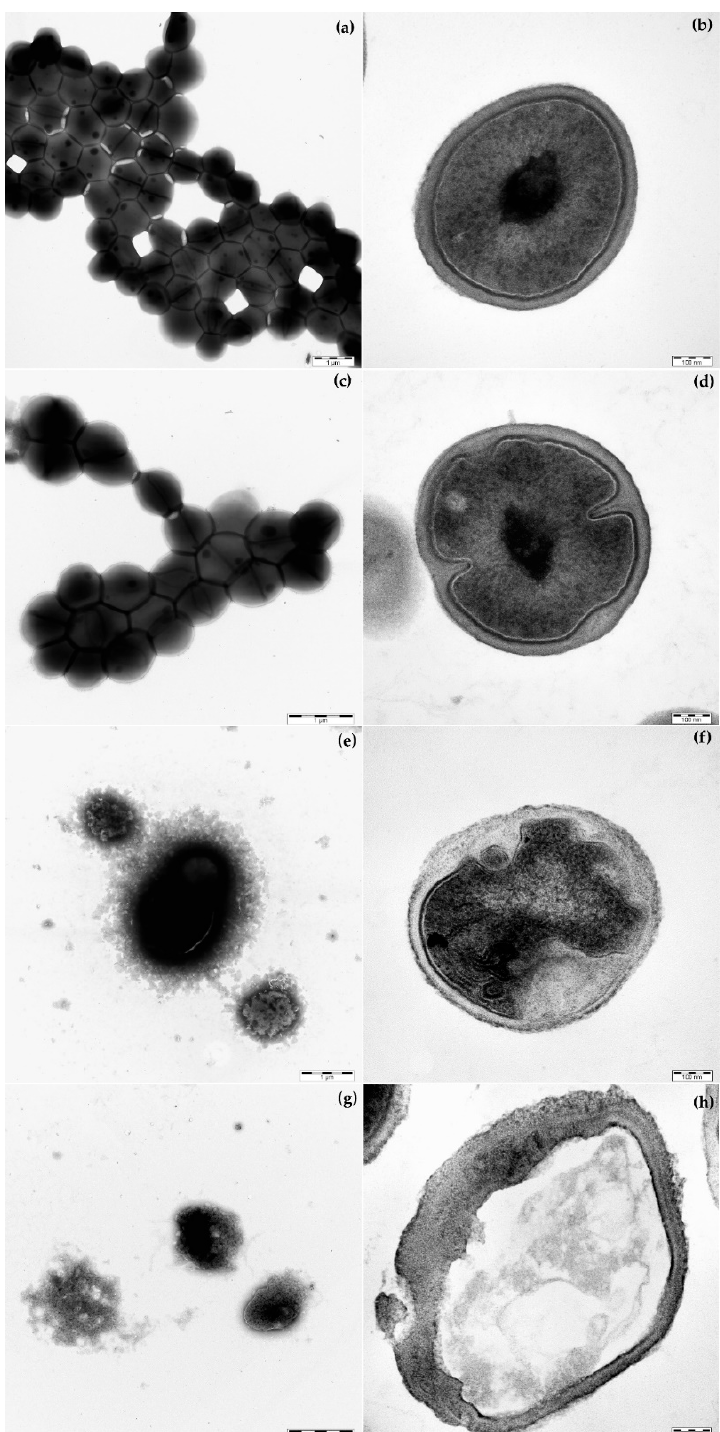
Figure 2. Transmission electron microscopy images of Staphylococcus epidermidis CNCTC 5671 affected by tetracycline (TET) and sodium salt of cobalt bis-dicarbollide (COSAN.Na) alone or their combination. ( a ) untreated control sample—negative staining; ( b ) untreated control sample— ultra-thin section; ( c ) TET 4.5 µ g/mL—negative staining; ( d ) TET 4.5 µ g/mL—ultra-thin section; ( e ) COSAN.Na 2.24 µ g/mL—negative staining; ( f ) COSAN.Na 2.24 µ g/mL—ultra-thin section; ( g ) TET 4.5 µ g/mL + COSAN.Na 2.24 µ g/mL—negative staining; ( h ) TET 4.5 µ g/mL + COSAN.Na 2.24 µ g/mL—ultra-thin section. Scale bar = 1 µ m ( a , c , e , g ) or 100 nm ( b , d , f , h